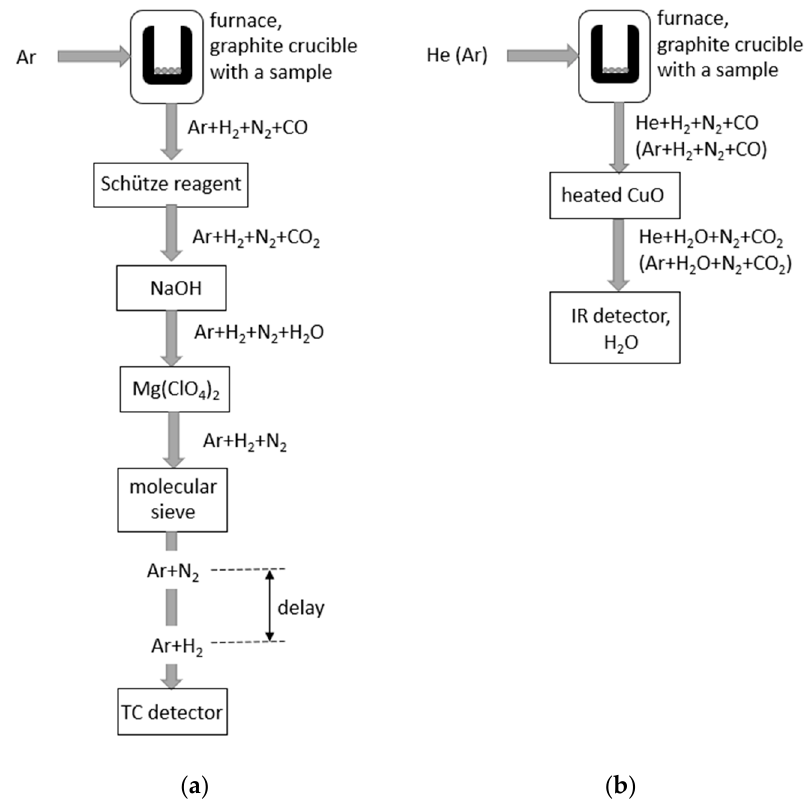
Figure 2. Hydrogen analysis by IGF with TC detection ( a ) and IR detection ( b ). Table 1. Reactions and reagents used to modify the gas composition between the furnace and the detector in the IGF